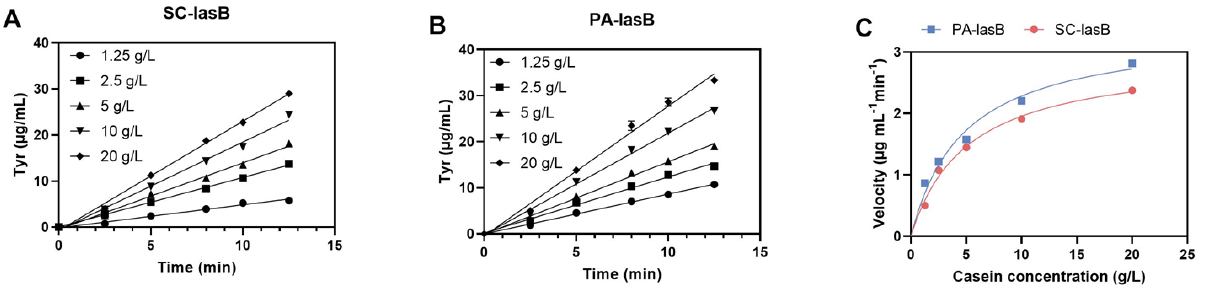
Figure 4. Estimation of the enzyme kinetic of SC-lasB and PA-lasB. ( A ) The amount of tyrosine released ( µ g/mL) during different reaction times for SC-lasB. ( B ) The amount of tyrosine released ( µ g/mL) during different reaction times for PA-lasB. ( C ) Michaelis–Menten plot of SC-lasB and PA-lasB at different concentrations of casein.